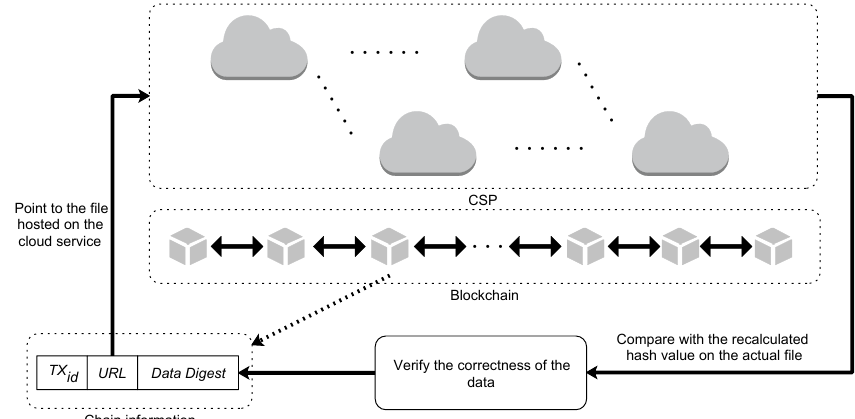
Figure 5. Relationship between chain data and cloud data.